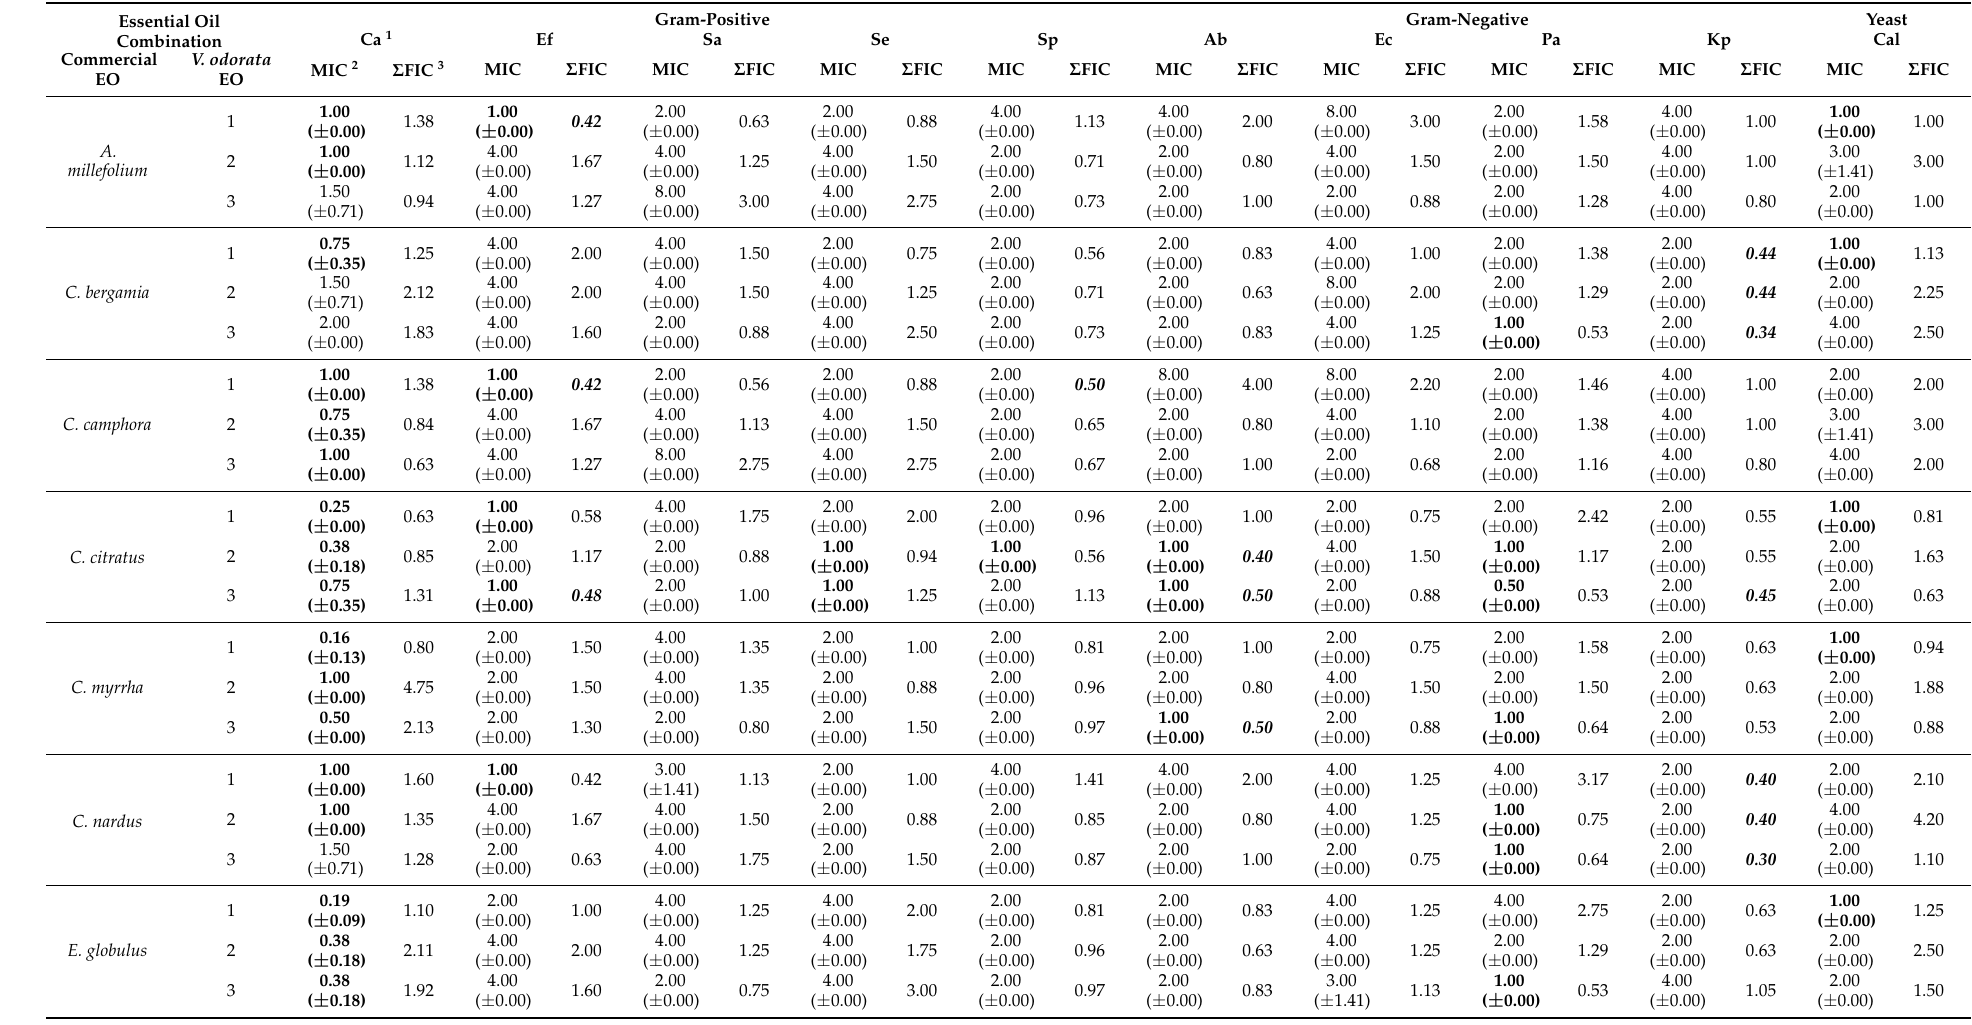
Table 4. Antimicrobial activity (mg/mL) of essential oils in combination with the different V. odorata chemotypes and Σ FIC values ( n =